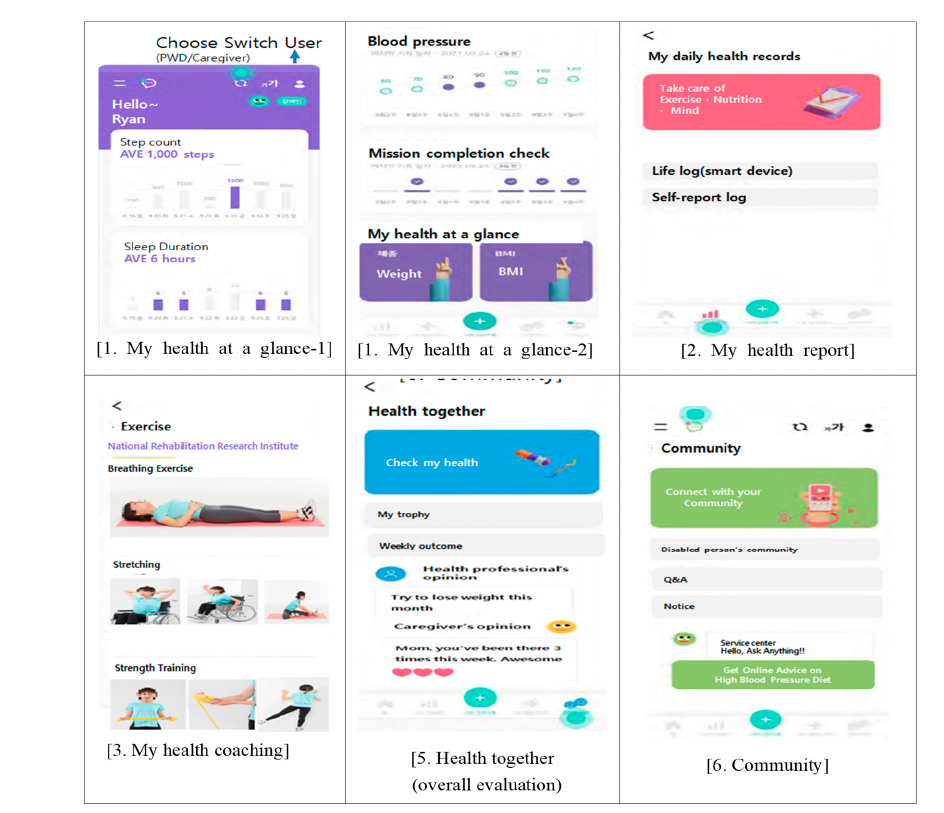
Figure 2. UIs of Three-Way Digital Healthcare System for the People with Disabilities and Their Caregivers.